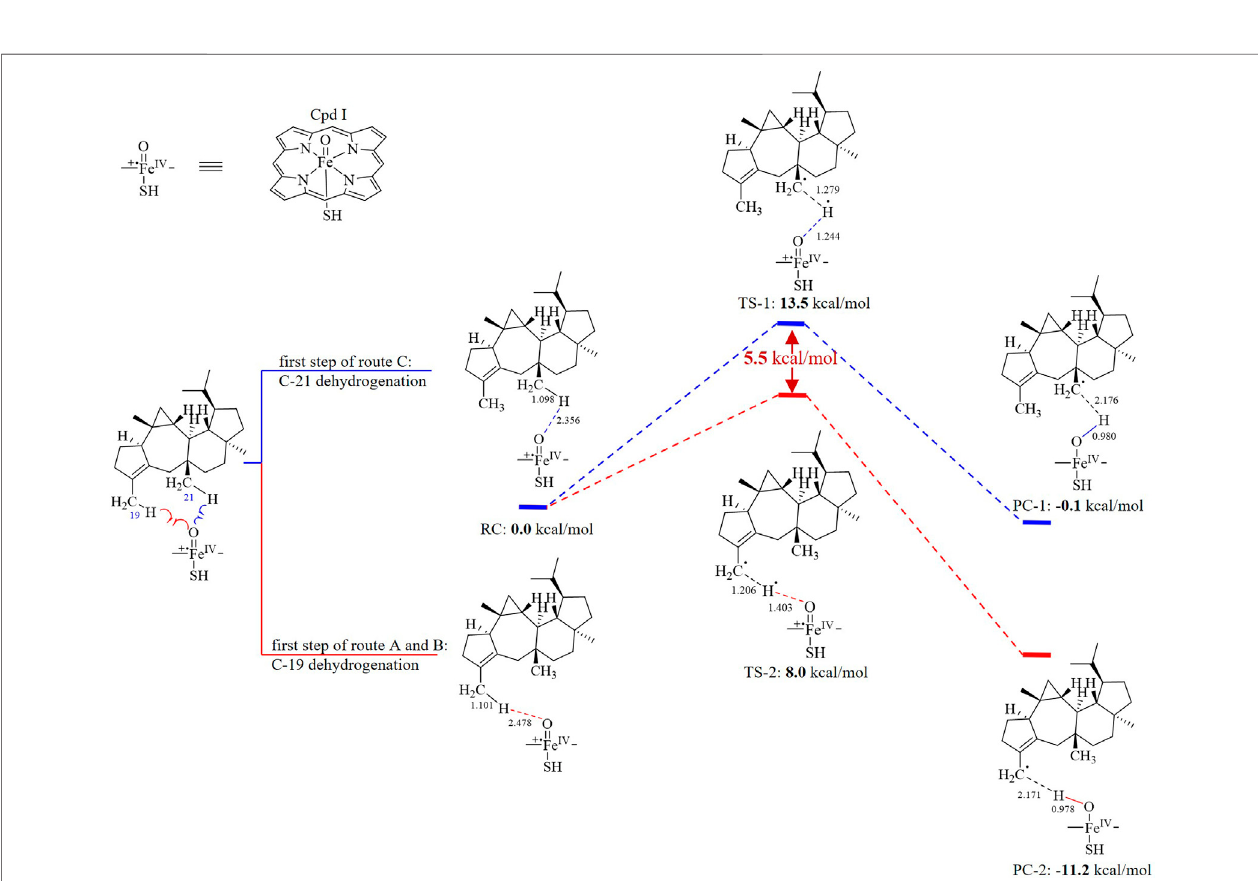
FIGURE 3 | Dehydrogenation energy calculations of C-19 dehydrogenation ( fi rst step of route A and B) and C-21 dehydrogenation ( fi rst step of route C).